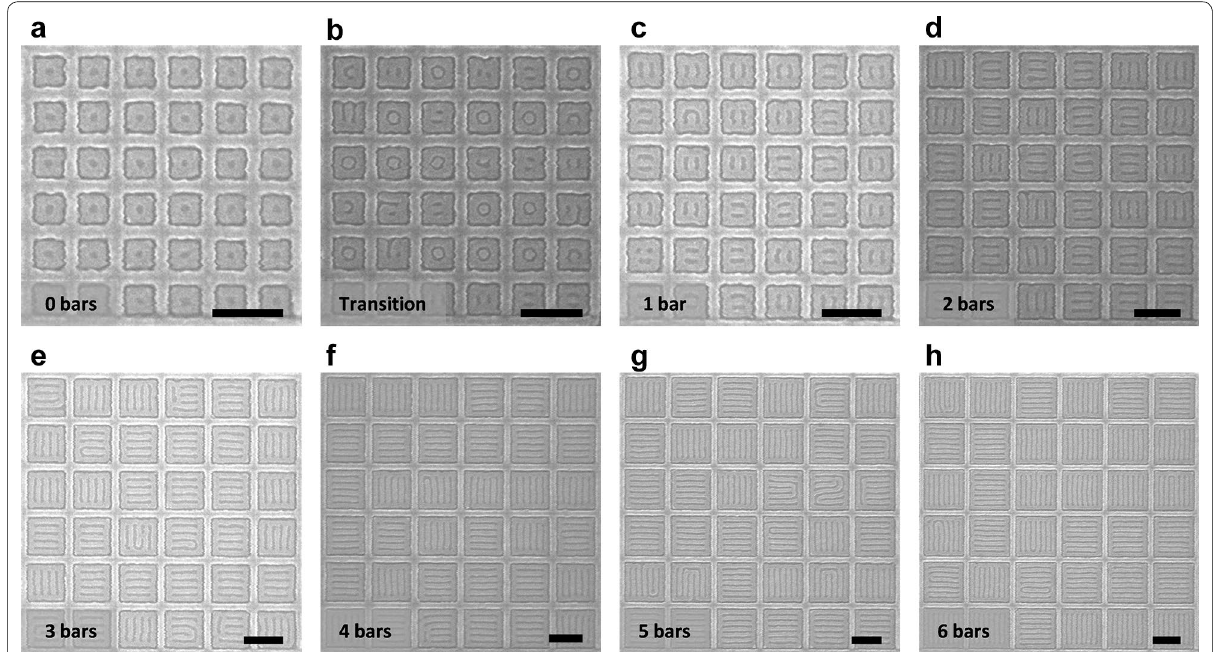
Fig. 2 SEM images of ladder‑shaped block copolymer patterns inside square confinement. a , c – h Show commensurate conditions while b shows transition between a one‑state system ( a ) and a two‑state system ( c ) inside incommensurate confinement dimensions. Width of the square confinement was a 2.2 L 0 , b 2.8 L 0 , c 3.0 L 0 , d 4.1 L 0 , e 5.1 L 0 , f 6.1 L 0 , g 7.1 L 0 , and h 8.1 L 0 ( L 0 bars were formed inside an outer ring. Scale bars, 200